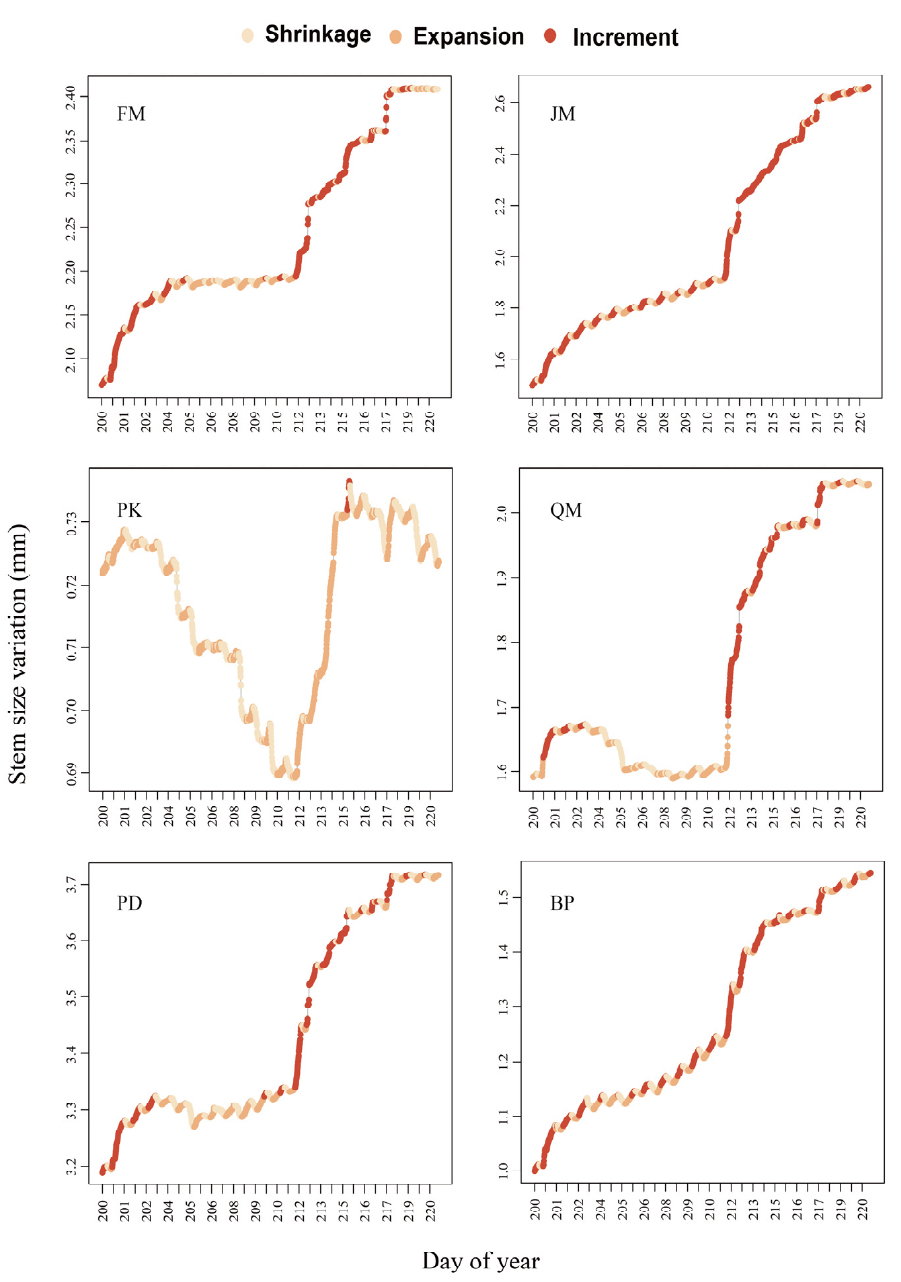
Figure 4. Stem diameter variation of six tree species during DOY200-220. The “shrinkage, expansion, increment” represent the three phases of the stem-cycle approach. The data are available at 15-min intervals. FM: Fraxinus mandshurica ; JM: Juglans Mandshurica Maxim.; PK: Pinus koraiensis Sieb. et Zucc.; QM: Quercus mongolica Fisch.; PD: Populus davidiana Dode.; BP: Betula platyphylla Suk. The variation patterns of stem diameter shrinkage of the six tree species under